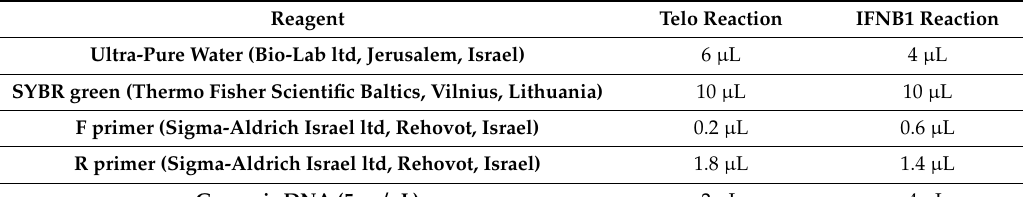
Table A8. Telomere length qPCR reaction volumes per 1 reaction.